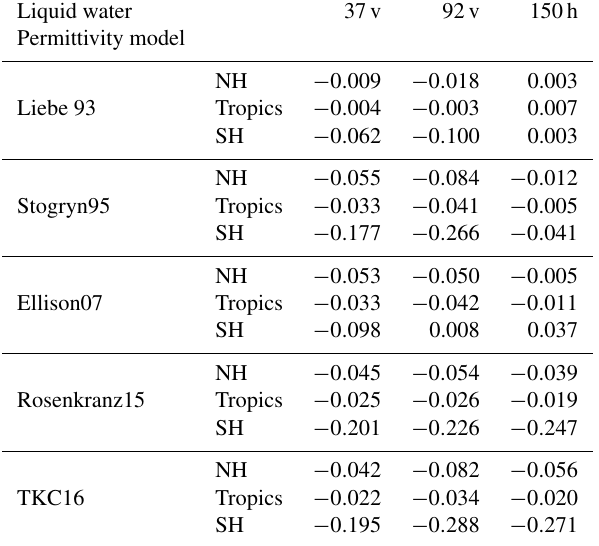
Table 3. Mean difference in simulated brightness temperature [K] between the newer liquid water permittivity models and the current Liebe89 for 37v, 92v and 150h at locations of all selected SSMIS- F17 observations over the time period 1 to 31 August 2016 for the Northern Hemisphere (NH: 20 to 90 ◦ N), tropics (20 ◦ N to 20 ◦ S) and Southern Hemisphere (SH: 20 to 90 ◦